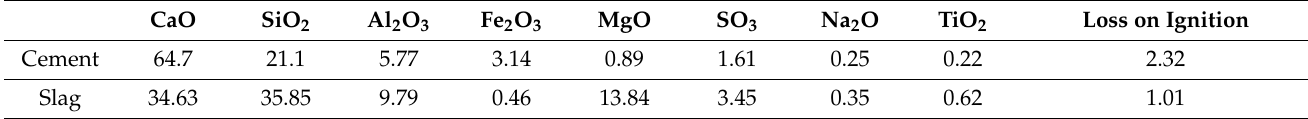
Table 1. Chemical composition of cement and slag.